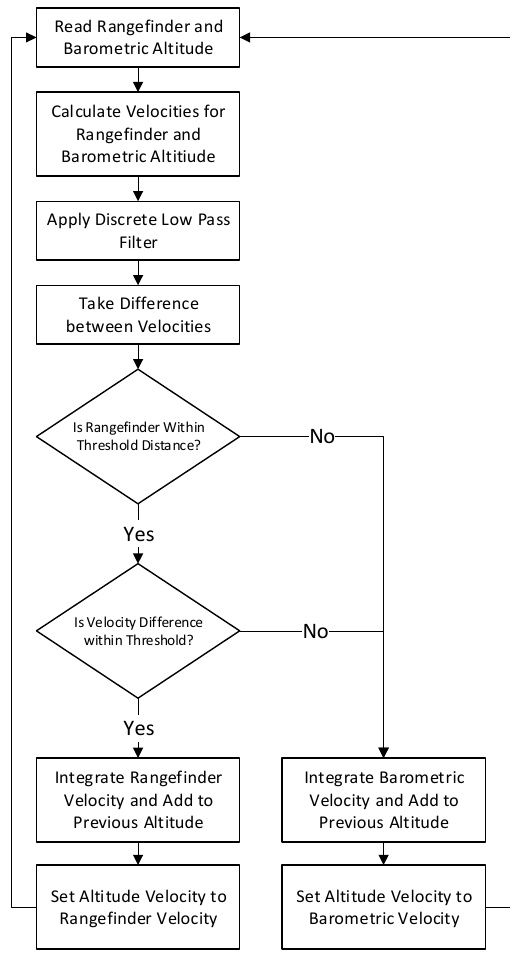
Figure 6. Hybrid altitude state machine.